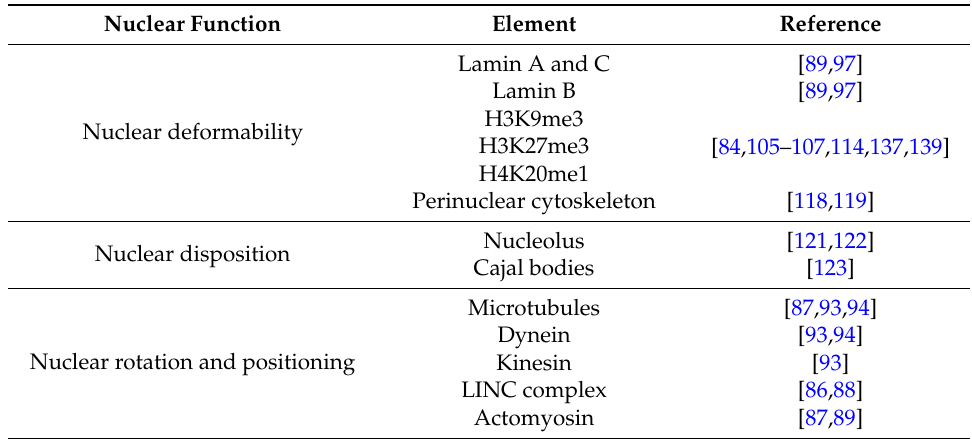
Table 2. Overview of the nuclear changes that facilitate cell